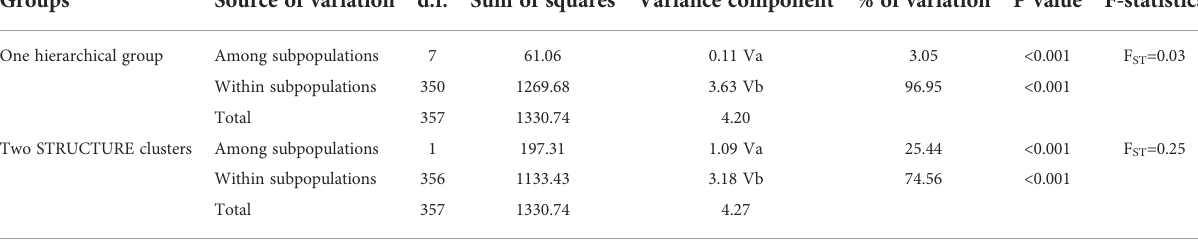
TABLE 5 Analysis of molecular variance (AMOVA) for Cryptolepis sanguinolenta subpopulations using 15 microsatellite loci.